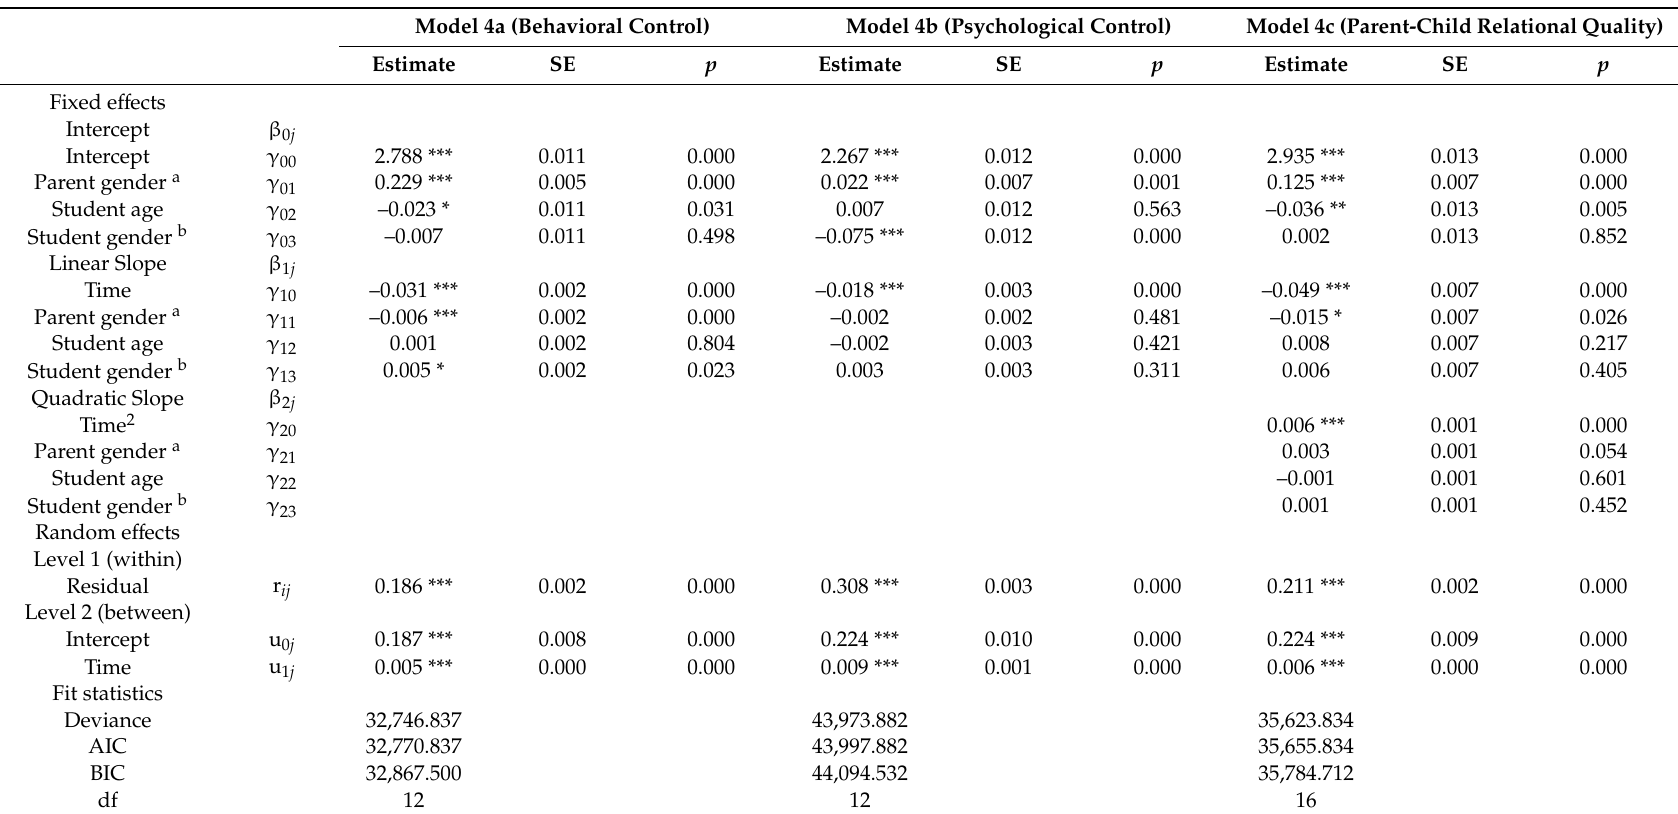
Table 6. Results of IGC models with level-2 predictors for parental behavioral control (Model 4a), psychological control (Model 4b) and parent-child relational quality (Model